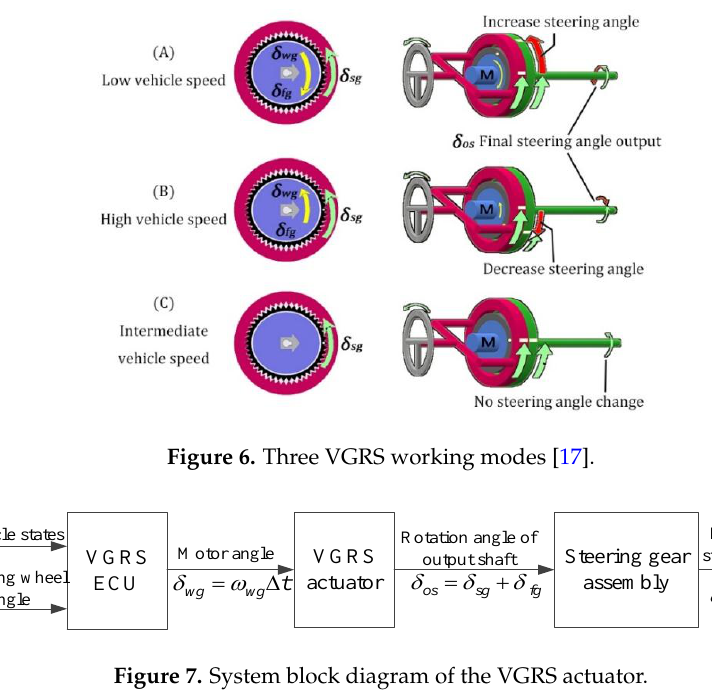
Figure 7. System block diagram of the VGRS actuator.